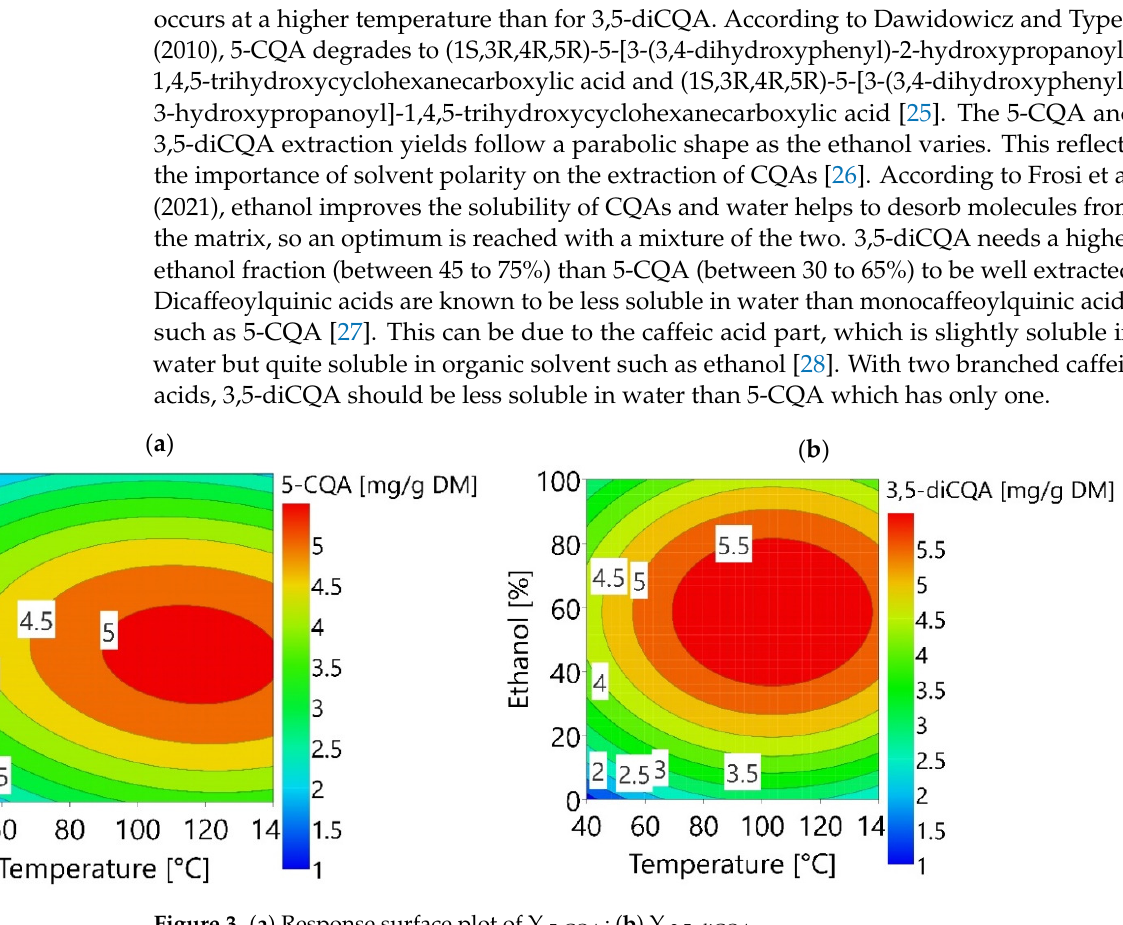
5-CQA ; ( b ) Y 3,5-diCQA.